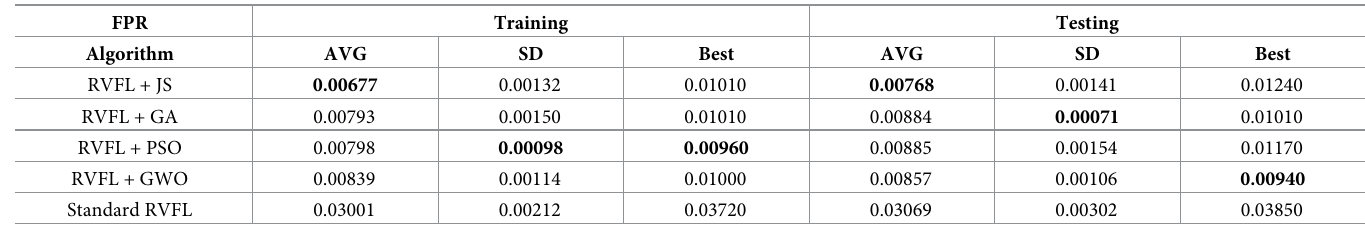
Table 10. Measurement FPR of RVFL+ JS against other metaheuristic algorithms.